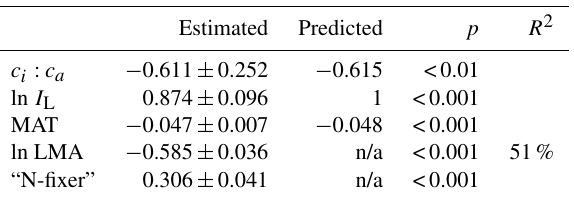
Table B1. Linear regression coefficients for ln (N mass × 100) (gg − 1 ) as a function of c i : c a (from δ 13 C), ln (mean canopy